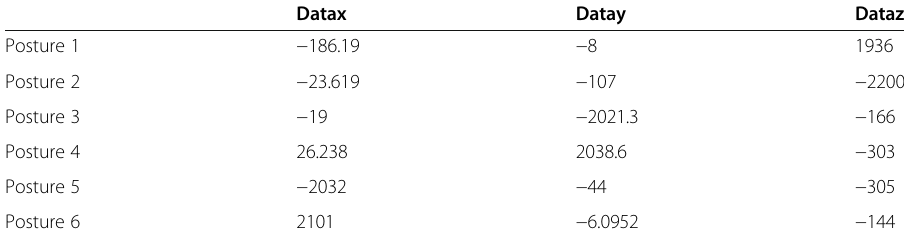
Table 4 Accelerometer ’ s zero offset and scale factor calibration results in different attitudes